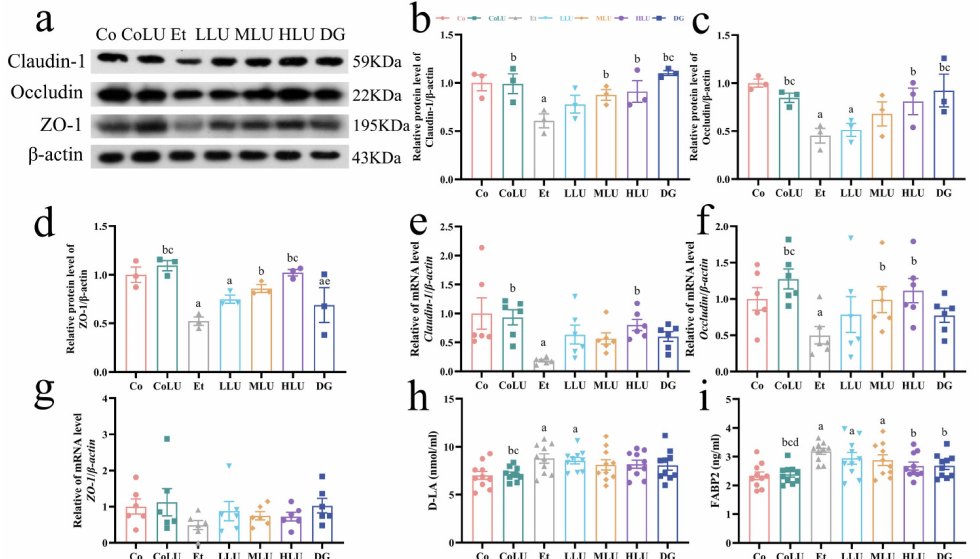
Figure 6. Effect of lutein on the ileal barrier. ( a ) The protein expression levels of Claudin-1 ( b ), Occludin ( c ), and ZO-1 ( d ) ( n = 3/group). The gene expression levels of Claudin-1 ( e ), Occludin ( f ), and ZO-1 ( g ) ( n = 6/group). Levels of ( h ) D-Lactic acid (D-LA) and ( i ) intestinal fatty acid binding protein (FABP2) ( n = 10/group). The data were shown with mean ± SEM. Co: normal control group; CoLU: the medium-dose lutein control group; Et: ethanol model group; LLU: the low-dose lutein intervention group; MLU: the medium-dose lutein intervention group; HLU: the high-dose lutein intervention group; DG: positive control group. a p < 0.05 vs. Co group, b p < 0.05 vs. Et group, c p < 0.05 vs. LLU group, d p < 0.05 vs. MLU group, e p < 0.05 vs. HLU